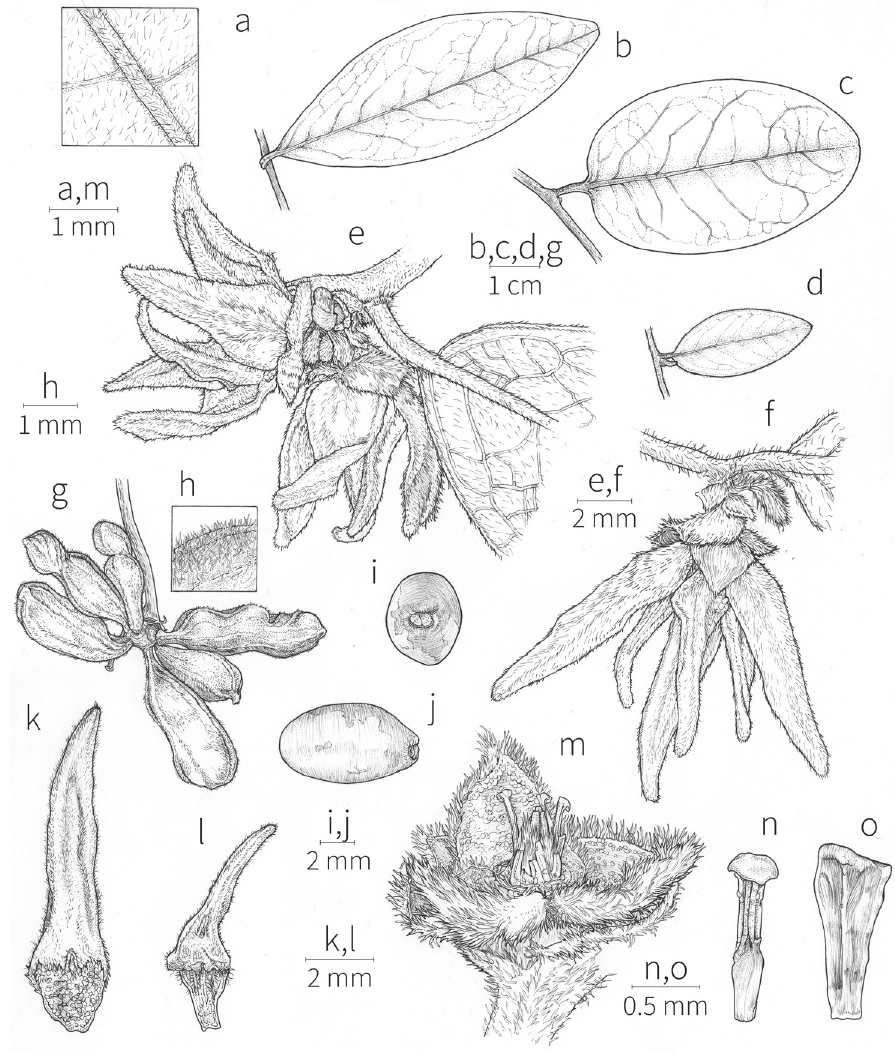
Figure 30. Xylopia tomentosa . A Close-up of abaxial surface of leaf B–D Leaves to show range of vari- ation E, F Inflorescences G Fruit H Close-up of monocarp surface, showing pubescence I Seed, micro- pylar view J Seed, side view K Outer petal, adaxial view L Inner petal, adaxial view M Receptacle, with sepals, some stamens, and ovaries still attached N Stamen, abaxial view O Outer staminode, abaxial view. A, D based on Brummitt et al. 14111 (K) B, G, H from Exell & Mendonça 374 (BM) C from Brummitt et al. 14068 (MO) E from Milne-Redhead 2528 (K) F, K, L, N, O from Holmes 1056 (K) I, J from Brum- mitt et al. 14068 (K) M from Pocock 445